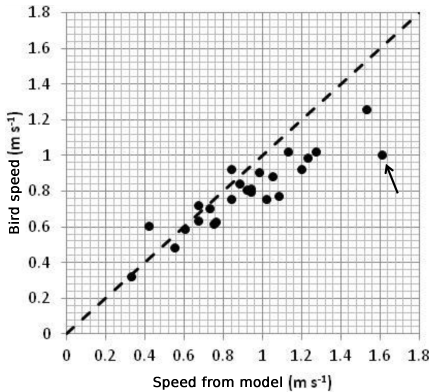
Figure 7. Plot of maximum bird speed in grid elements against maximum speed from the model of Lewis et al. (2015), both at mean tidal range. The dashed line represents a perfect fit. The point marked with an arrow is discussed in the text. The bird speeds have been adjusted to an average over the water depth by multiplying by a factor of 0.85 in order to match the